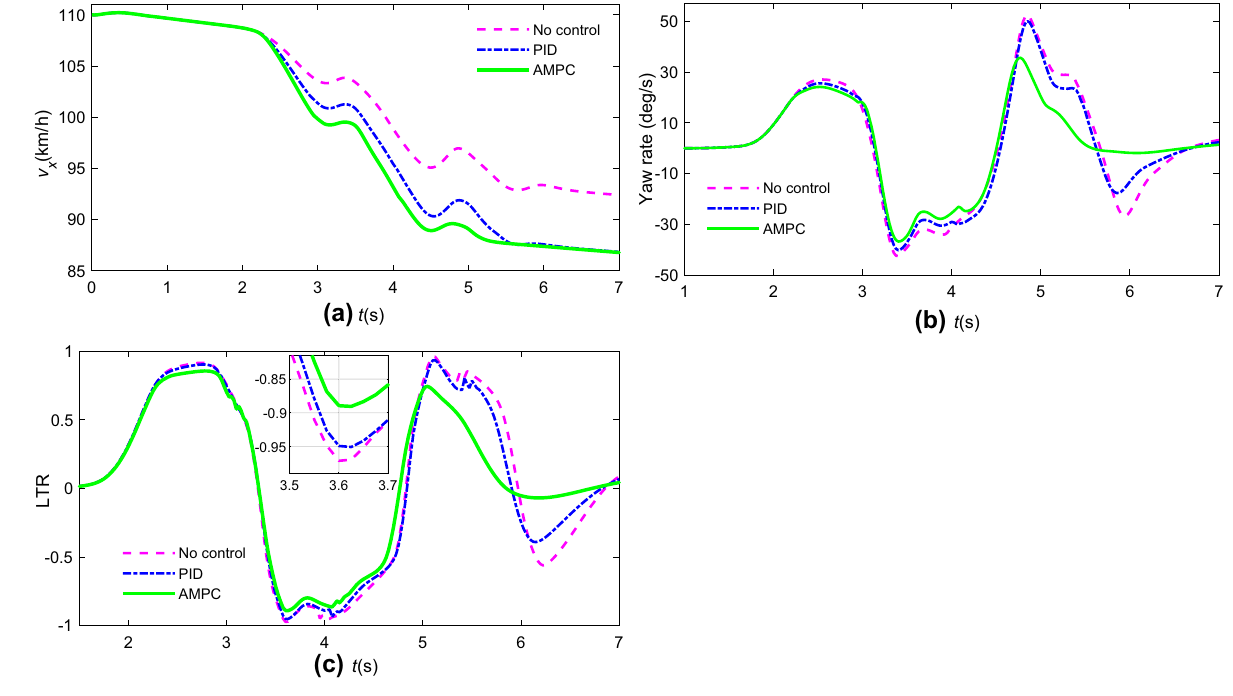
Figure 18. Stability index by different controllers: ( a ) vehicle speed; ( b ) yaw rate; ( c ) LTR.